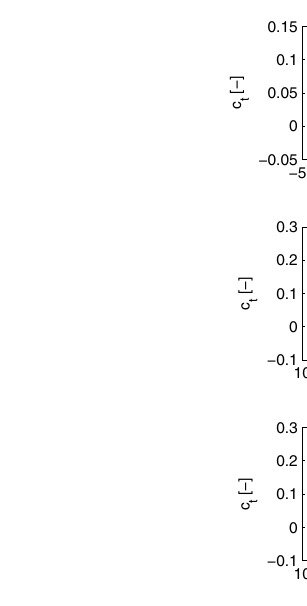
ther the equidistant point spacing means that the small drop in the loading to zero at the very last blade section is not so finely resolved. At 0 ◦ wind direction, the flow is attached on the whole blade; see Fig. 11b. Therefore, the lift gradients are large and the trailed vorticity modeling has a larger influence on the loading. Both the mean aerodynamic forces as well as the standard deviations of these forces are reduced